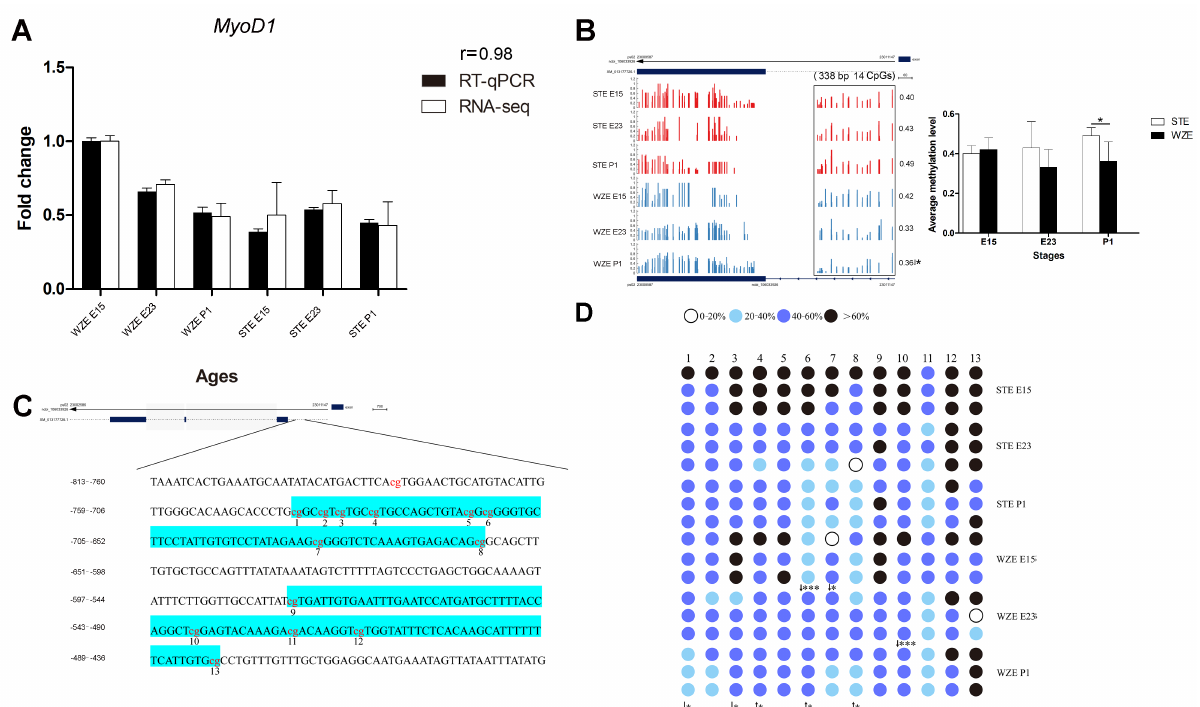
Figure 7. Validation of the association between DNA methylation and gene expression in the MyoD1 promoter region. ( A ) RT − qPCR and RNA-seq validation of MyoD1 expression ( n = 3). ( B ) MyoD1 promoter and first exon DNA methylation level as shown by IGV software based on WGBS data. Regions around TSSs are marked in black boxes with average DNA methylation level shown beside the boxes. The length and number of CpGs in this box is marked in the figure. Quantitative analyses of indicated boxes are presented. ( C ) A total of 13 methylation sites within the promoter region ( − 480 bp to − 723 bp) of MyoD1 were examined in WZE and STE by pyrosequencing. ( D ) Pyrosequencing results of 13 methylation sites within the promoter region of MyoD1. Different colors represent different DNA methylation levels, which are indicated in the figure. Downward arrows indicate a lower DNA methylation level in comparison with STE, upward arrows indicate a higher DNA methylation level in comparison with STE. * p < 0.05; *** p <